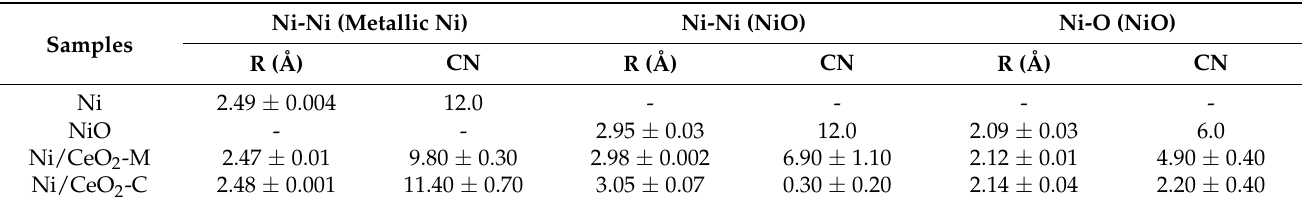
Table 2. Fitting details of Ni/CeO 2 -C and Ni/CeO 2 -M catalysts.